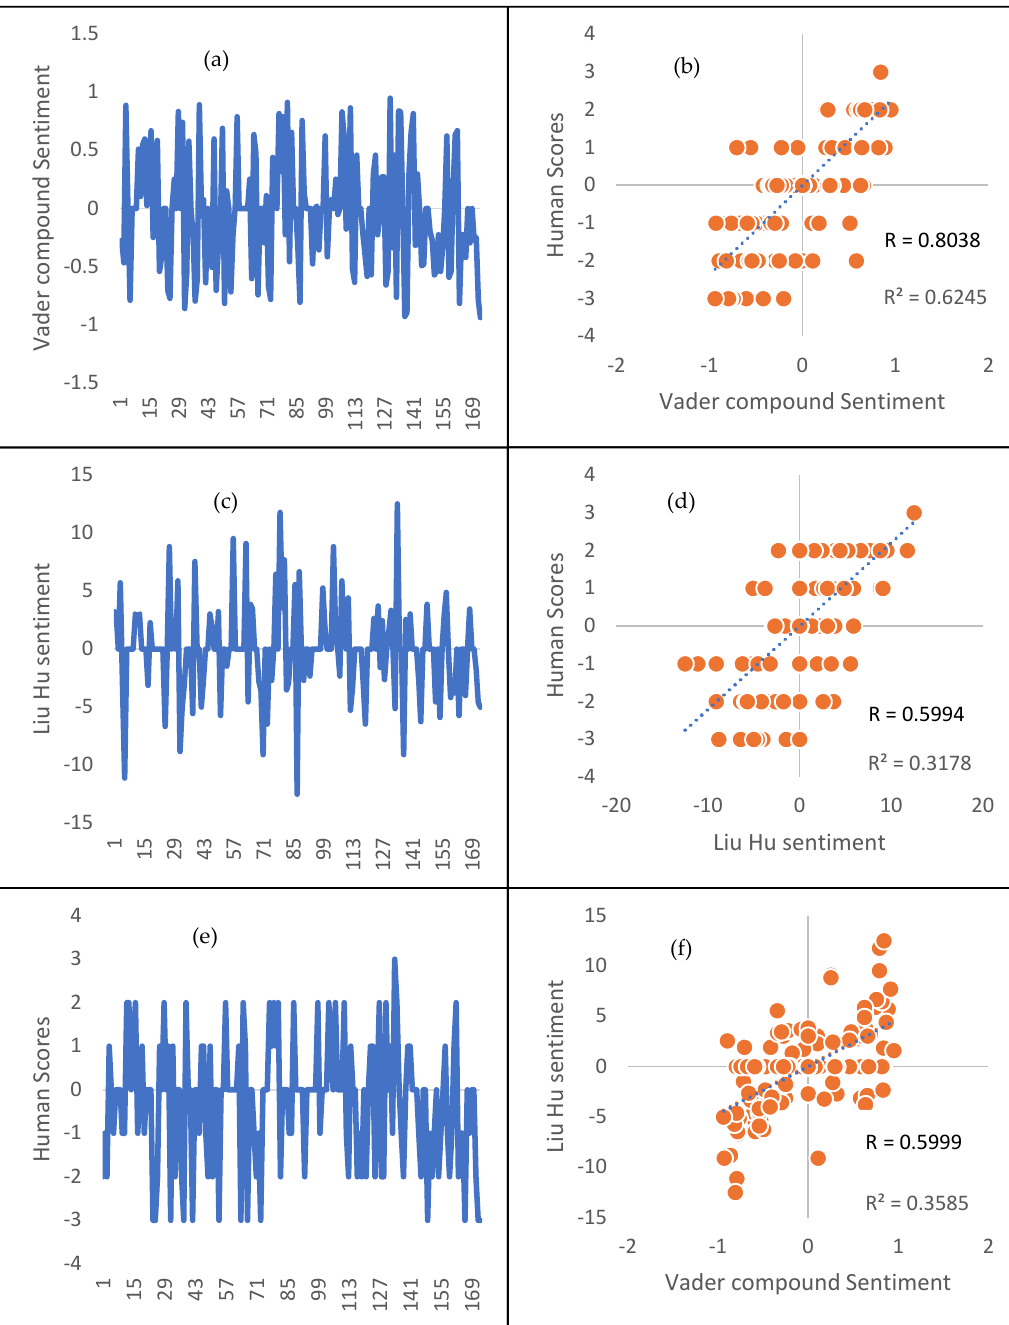
Figure 8. Subplots showing validation results of the tweet sentiment classification. Subplot: ( a ) Line plot of VADER sentiment scores; ( b ) Scatter plot of Human and VADER sentiment scores; ( c ) Line plot of Liu Hu sentiment scores; ( d ) Scatter plot of Human and Liu Hu sentiment scores; ( e ) Line plot of Human sentiment scores; ( f ) Scatter plot of Liu Hu and VADER sentiment scores.